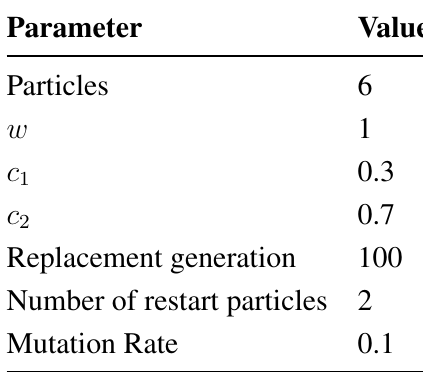
Table 2. Parameters of µ -PSO.